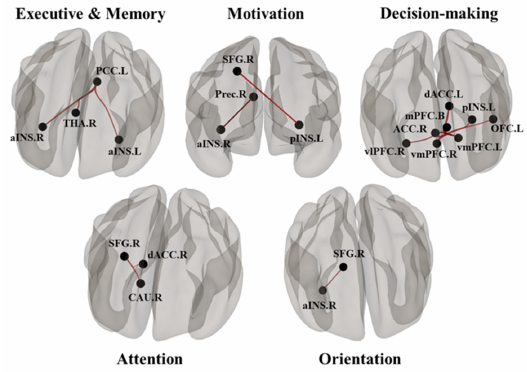
Figure 2. The functional connections between ROIs in CON and DMN, which showed high correlations with improved cognitive functions (executive and memory, motivation, decision-making, attention), as revealed by neurobehavioral tests.